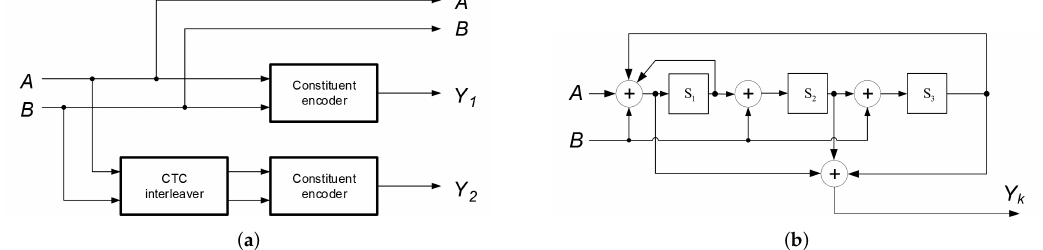
Figure 2. Block diagram of CTC encoder: ( a ) CTC encoder; and ( b ) constituent